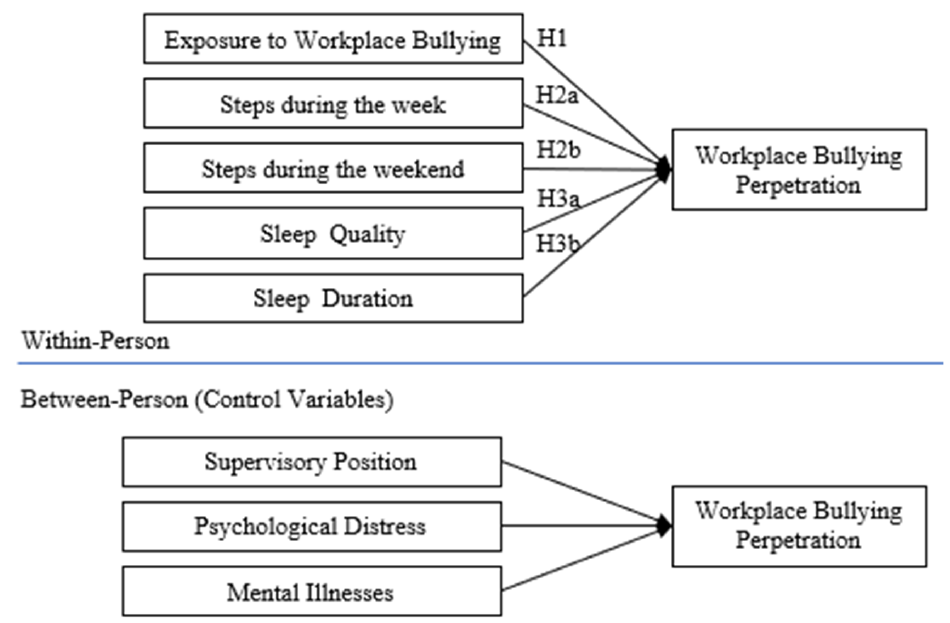
Figure 1. Hypothesized relationships among study variables.